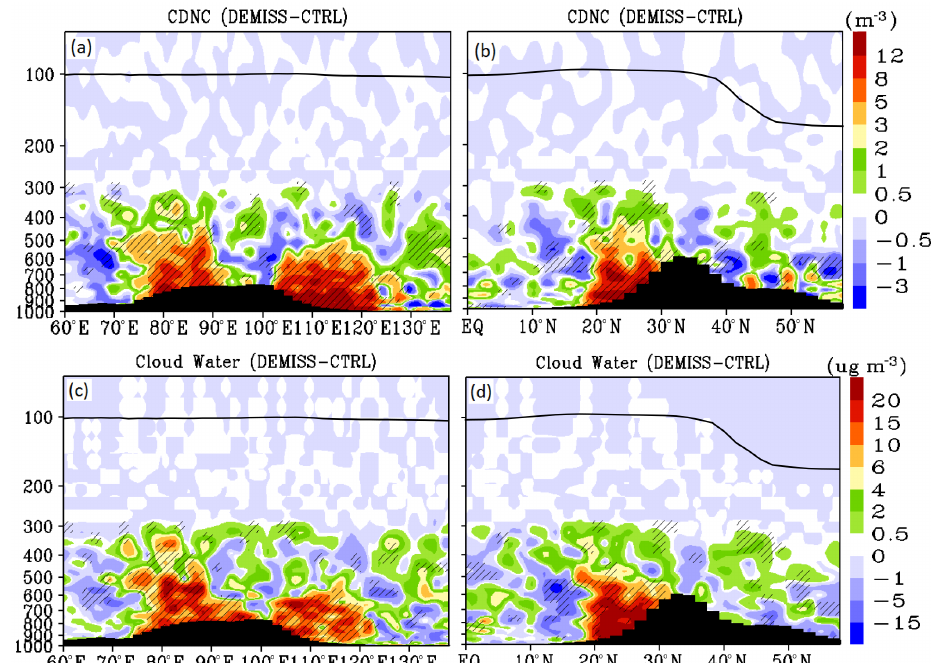
Figure 6. Distribution of anomalies (Demiss-CTRL) averaged for the monsoon season. (a) CDNC (m − 3 ) averaged for 15–35 ◦ N. (b) Same as (a) but averaged for 80–110 ◦ E. (c) Cloud water (µgm − 3 ) averaged for 15–35 ◦ N. (d) Same as (c) but averaged for 80–110 ◦ E. In panels (a–d) a thick black line shows the tropopause and black hatched lines indicate the 99% confidence level.